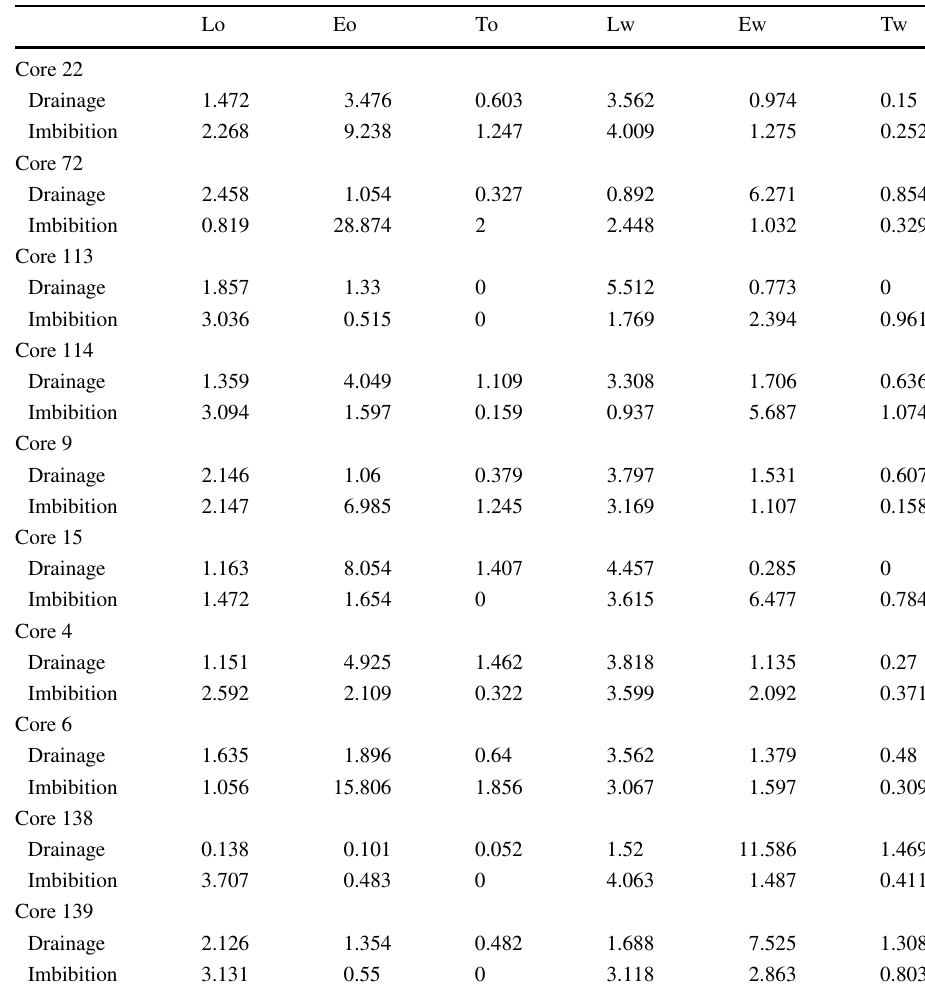
Table 1 Matching parameters for the well in steady-state drainage/imbibition experiment